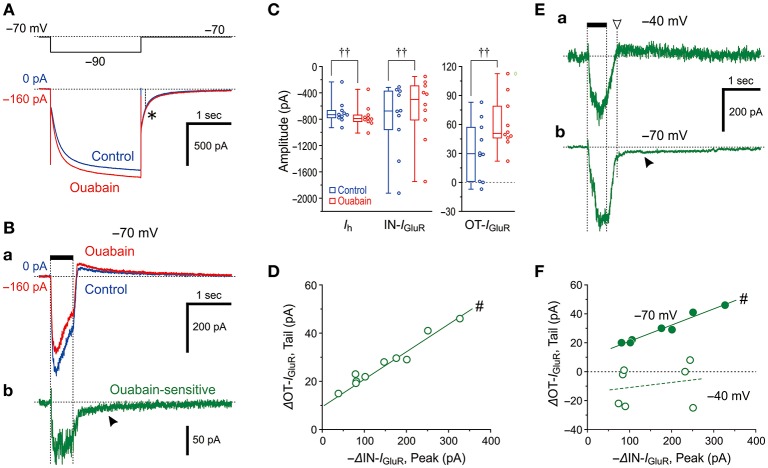
Effects of a Na+/K+ pump inhibitor on IGluR. (A,B) Current responses to a negative voltage pulse (−20 mV, 2 s) (A) and a 500-ms puff application of 0.2 mM AMPA (Ba) recorded before (blue traces) and during the application of 50 μM ouabain (red traces). The ouabain-sensitive IGluR, acquired by subtraction of the red trace from the blue trace shown in Ba (Bb). Note the presence of a slow tail component, reflecting an enhancement of OT-IGluR (arrowhead). The baseline current levels were aligned. The asterisk denotes the unchanged tail current before and during the application of ouabain. (C) Box-and-whisker plots represent the amplitudes of the steady-state Ih, IN-IGluR, and OT-IGluR obtained before (blue) and after 50 μM ouabain application (red). ††: P < 0.01 (Wilcoxon signed-rank test). (D) Plot of the increase in amplitude of OT-IGluR against the decreases in the amplitudes of IN-IGluR following ouabain application. #: P < 0.05 (Pearson correlation coefficient). (E) The ouabain-sensitive IGluR at −40 mV (upper trace) and at −70 mV (lower trace). Note the absence and presence (filled arrowhead) of slow tail component that reflects an enhancement of OT-IGluR. The amplitude of OT-IGluR was measured at the time indicated by downward open arrowhead. (F) Plot of changes in amplitude of OT-IGluR against decreases in amplitudes of IN-IGluR at −70 mV and −40 mV. Note the presence and absence of significant correlation between the two amplitudes, at −70 mV and −40 mV, respectively. #: P < 0.05 (Pearson correlation coefficient).